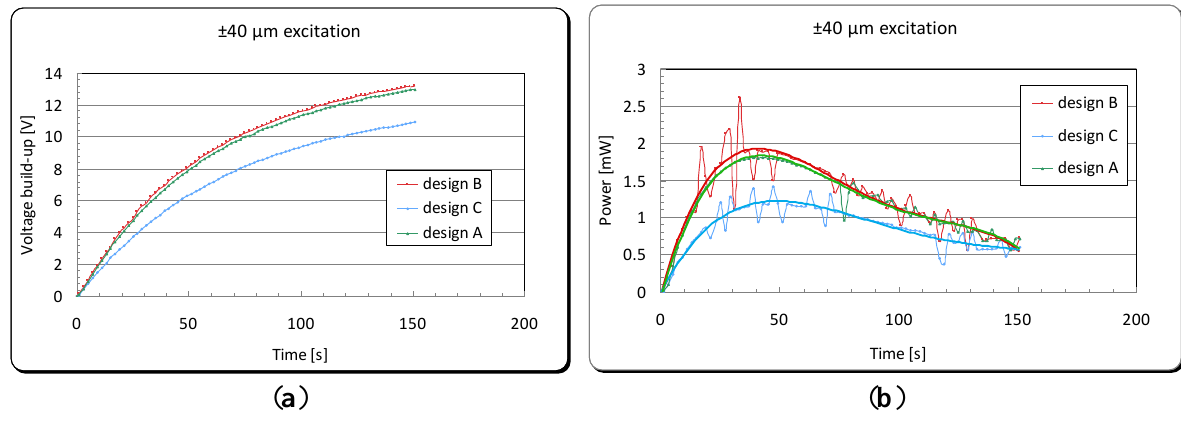
Figure 22. ( a ) Voltage build-up in a 2,200 μF capacitor and ( b ) the corresponding generated power by the energy harvester under ±40 μm amplitude of excitation.